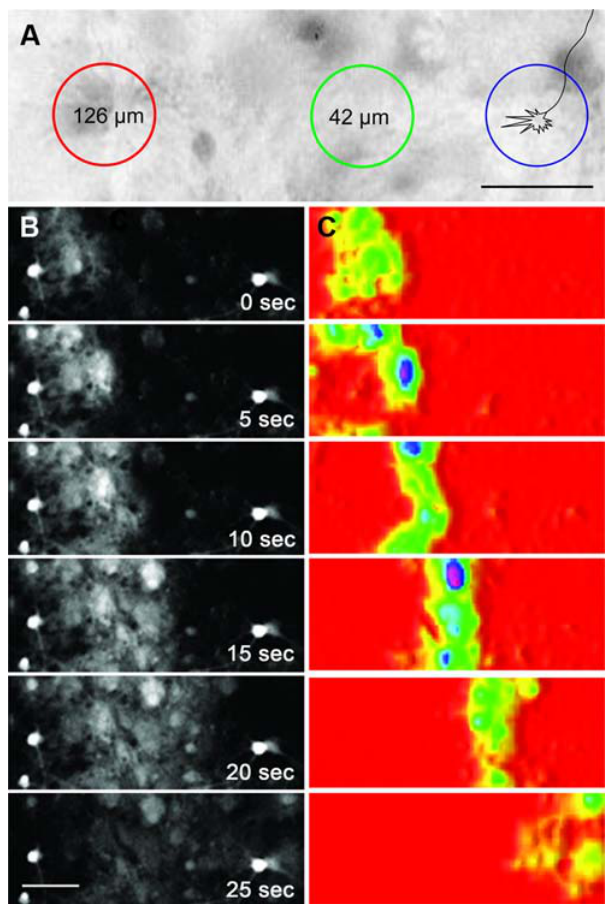
Figure 1. Local calcium elevation in astrocytes leads to the propagation of an intercellular Ca 2 + wave. Calcium levels were monitored using fluo-4 AM. (a) Illustration of the experimental protocol, which entailed the depolarization of a 42 m m diameter area either 42 m m or 126 m m to the right of an axonal growth cone. (b,c) Representative images of a glial wave. Panel c shows the progression of the wave front after image subtraction in ImageJ (W. Rasband, NIH). Scale bars, 50 m m.